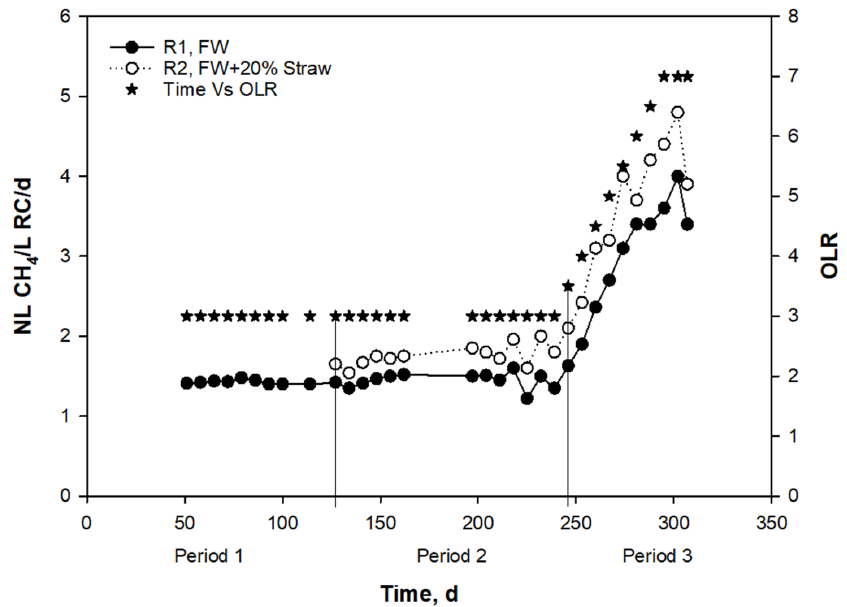
Figure 2. Volumetric methane production (VMP) obtained in R1 and R2 (target OLRs from FW were 3.0 gVS/L/d in Period 1 and Period 2 whereas 7.0 gVS/L/d in Period 3). 3.0 gVS/L/d in Period 1 and Period 2 whereas 7.0 gVS/L/d in Period